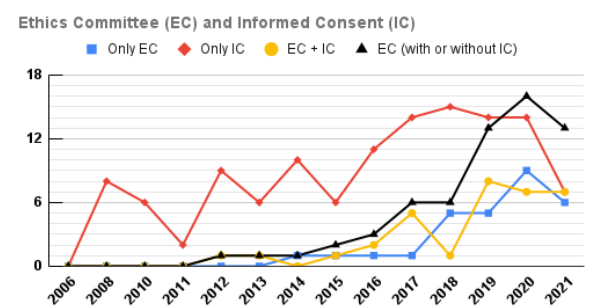
Figure 4. Research covering Ethical Committee and Informed